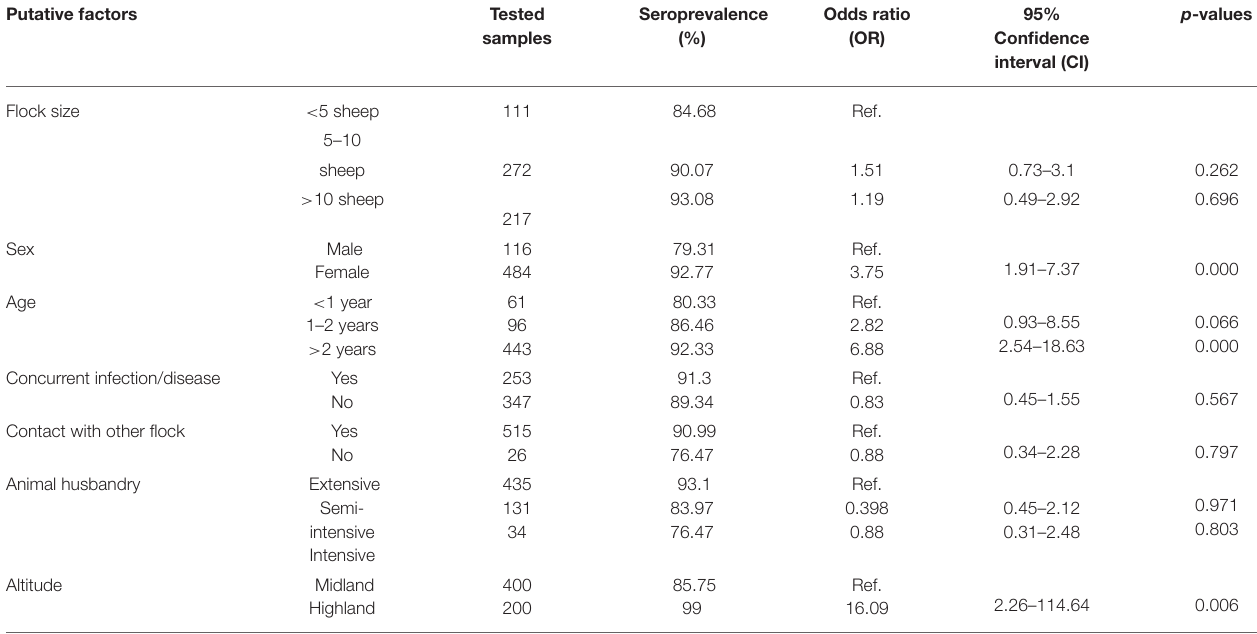
TABLE 4 | Univariable analysis of putative risk factors in relation to serological status using mixed effect logistic regression models including village as a random effect. Putative factors